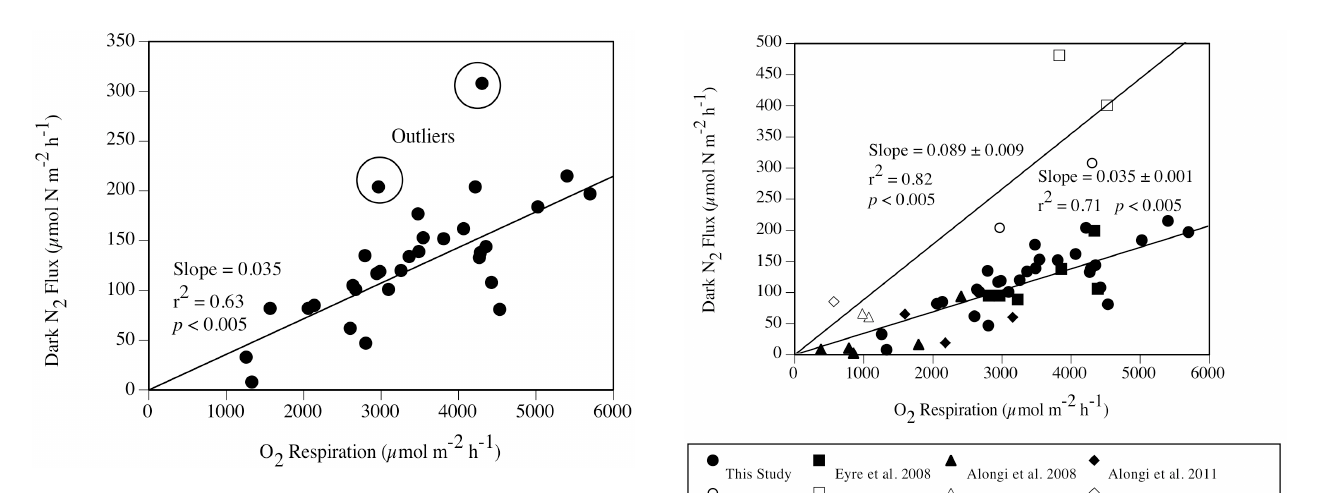
Fig. 5. Dark N 2 effluxes versus benthic respiration for all seasons in very coarse and coarse sands (individual chambers).